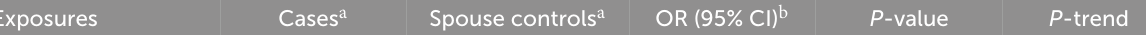
TABLE 5 Odds ratios and 95% confidence intervals for the likelihood of FL in relation to fish and seafood consumed in the year before last among cases and spouse controls. Exposures